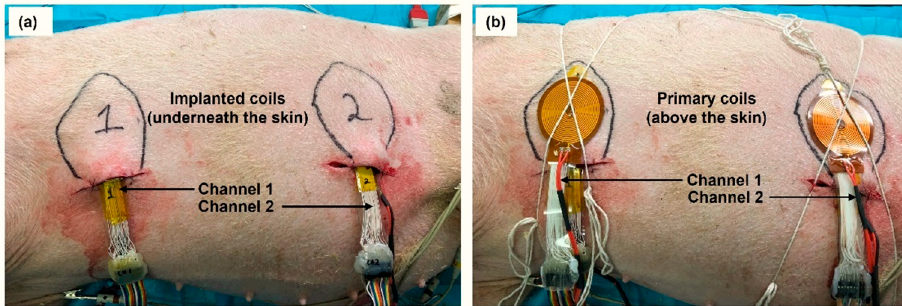
Figure 3. An illustration of thin and flexible coils with the position of the twelve NTC thermistors (numbered 1 to 12) adhered on the coil surface.